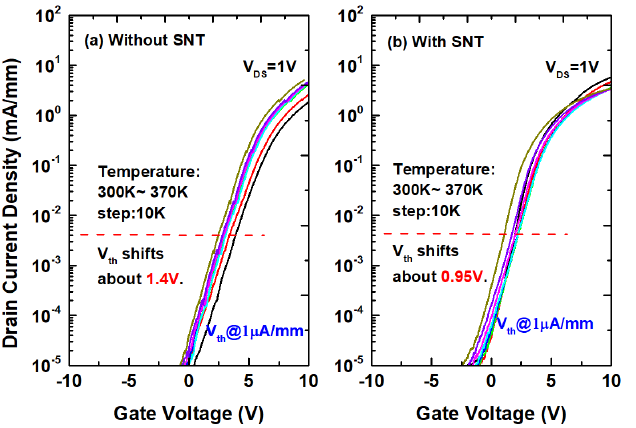
Figure 5. Temperature − dependent transfer characteristics of the all-GaN integrated MIS-HEMTs ( a ) without SNT and ( b ) with SNT.